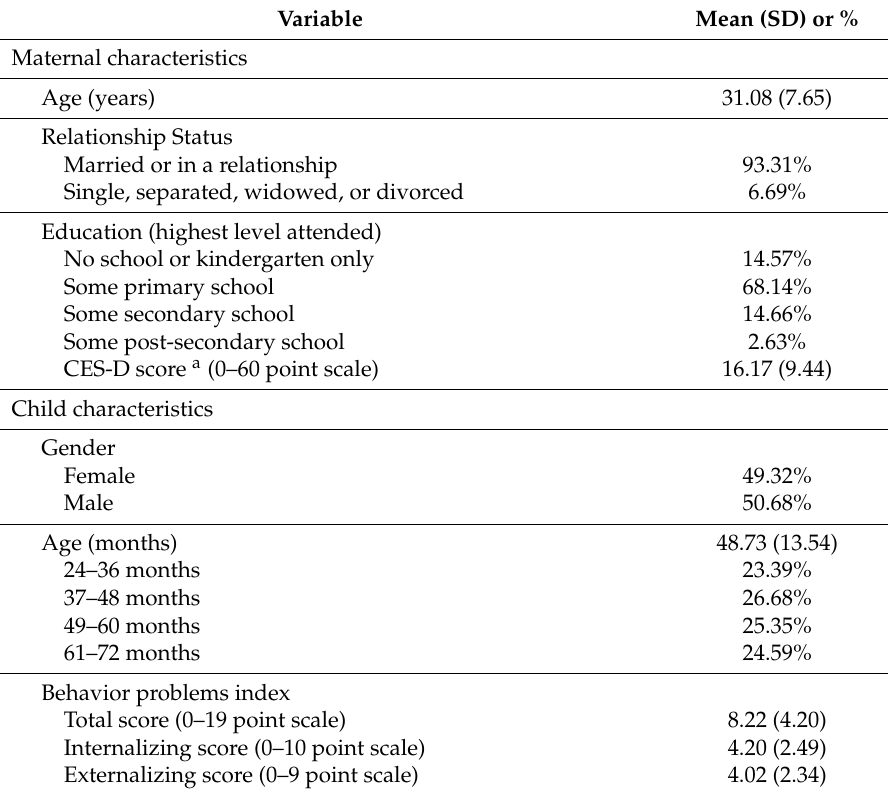
Table 1. Description of Study Participants by Variables of Interest (n = 5503 children, 4442 mothers).